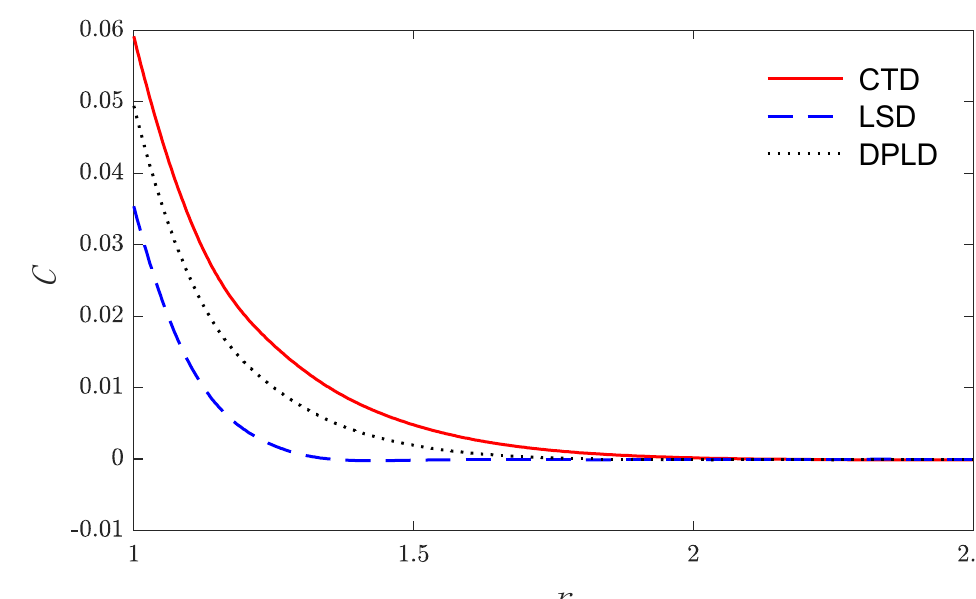
Figure 6. The concentration variation 𝐶 versus the redial distance 𝑟 for three models.